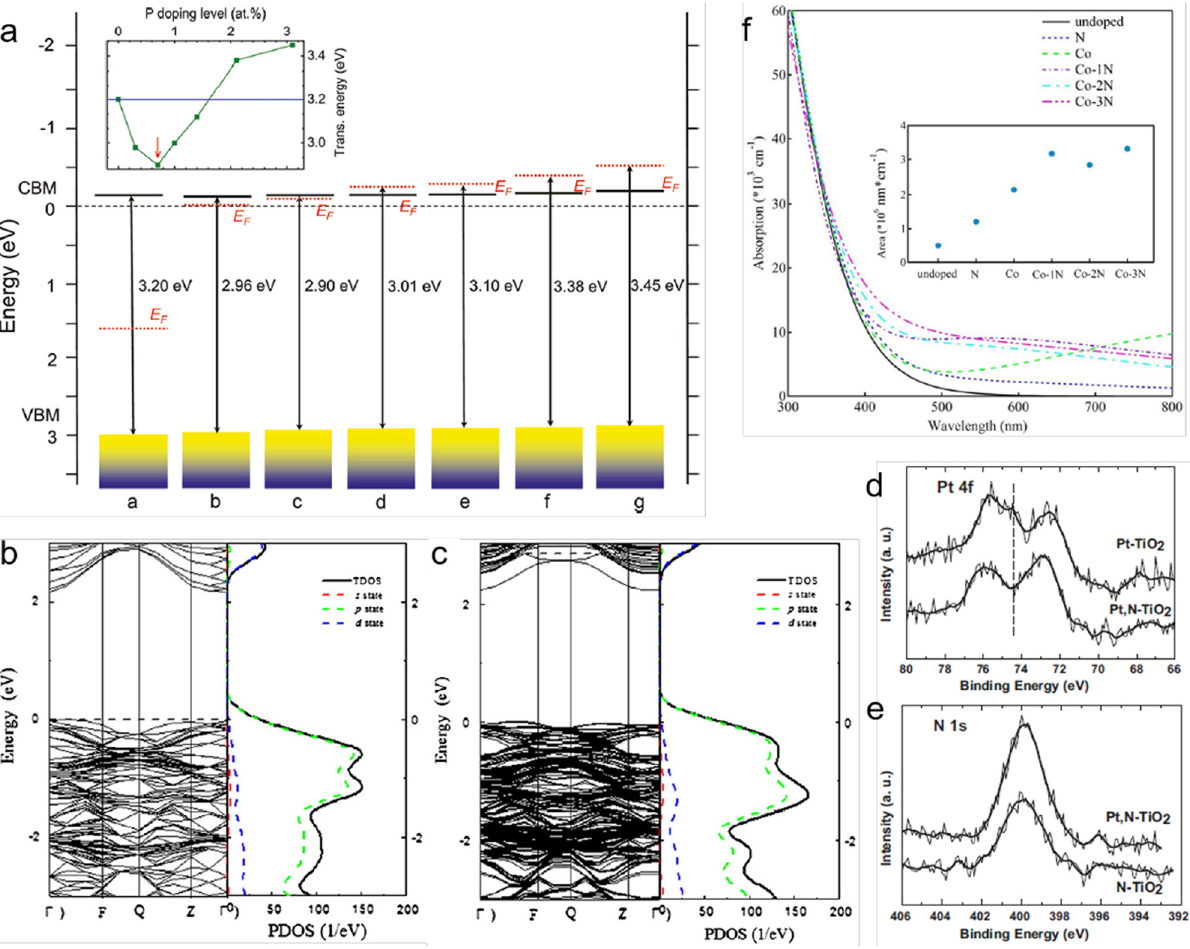
Figure 2: ( a ) Electron transition energy for the con fi gurations of pure anatase and anatase with various P doping levels, reprinted with permission from ref. [ 98 ] , Copyright ( 2011 ) American Chemical Society. Band structures of ( b ) TiO 2 , and ( c ) Ti 0.98 Mo 0.2 O 2 ,